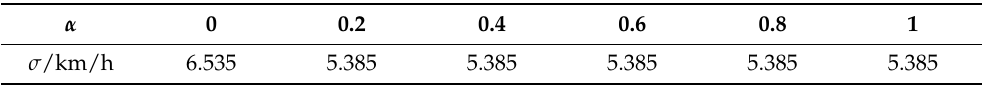
Figure 23. Comparison of the total torque between engine and motor corresponding to the compensable coefficient of different motors under working condition A. ( a ) α = 0; ( b ) α = 0.2; ( c ) α = 0.4; ( d ) α = 0.6; ( e ) α = 0.8; ( f ) α = 1. Table 7. Standard deviation of the torque corresponding to the compensable coefficient of different motors under working condition